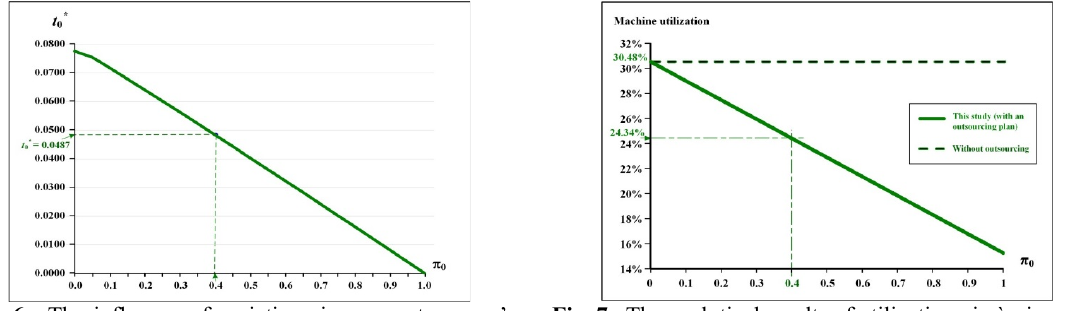
Fig. 7. The analytical results of utilization vis-à-vis π 0